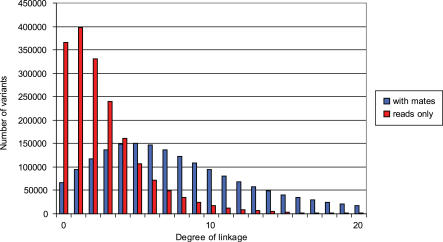
Degree of Linkage of Heterozygous VariantsThe distribution of the number of other variants to which a given variant can be linked using sequencing reads only or using mated reads as well is shown. Linkage of variants based on individual sequencing reads is limited, regardless of sequence coverage beyond a modest level, but is substantially increased by the incorporation of mate pairing information. The size of the effect is considerably more than simply doubling read length, due to variation in insert size; consequently, benefits of increasing sequencing coverage drop off much more slowly.